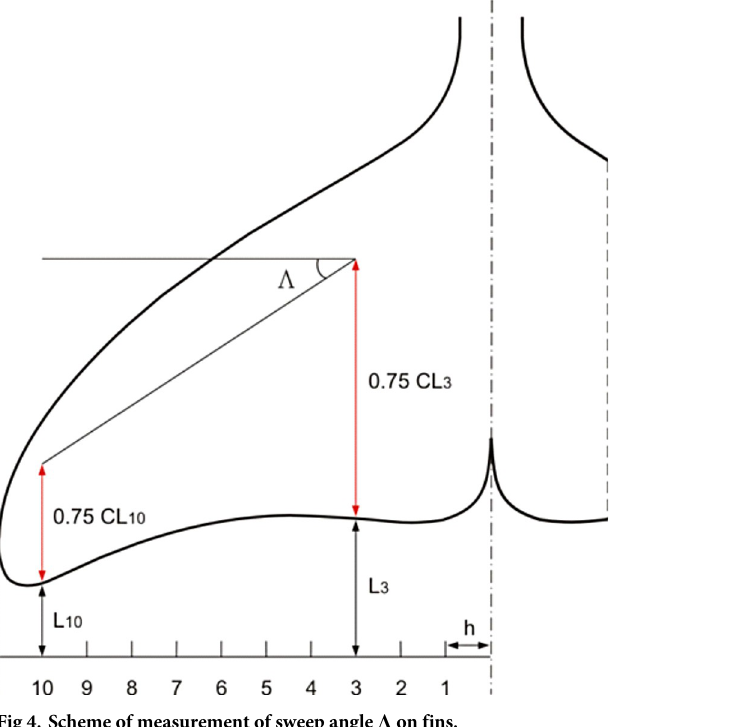
Fig 4. Scheme of measurement of sweep angle Λ on fins.